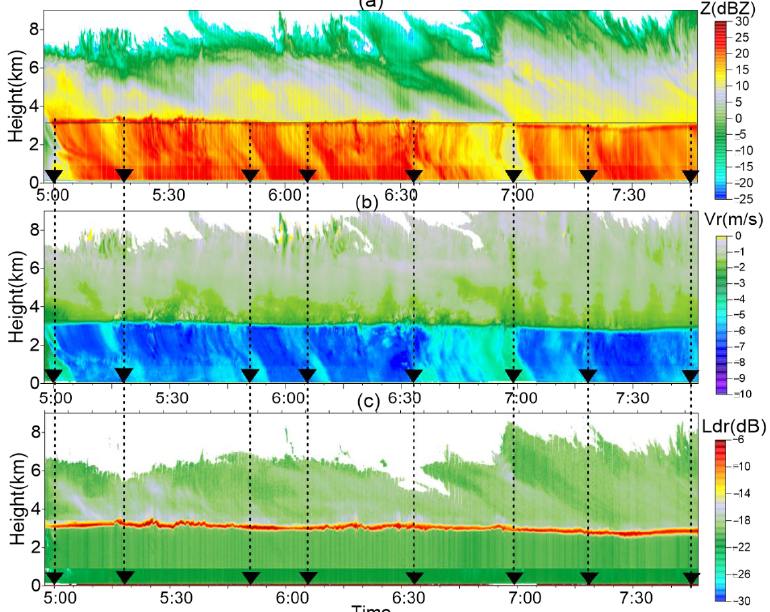
Figure 11. Time – height cross sections of the stratiform rain detected by CR on 19 August 2021, from 4:47 – 7:57 with ( a ) Z (dBZ), ( b ) Vr (m/s) and ( c ) LDR (dB). The black triangles on the horizontal axis mark the BP occurring moment. The black horizontal lines mark the 0 °C line. The black dotted vertical lines extend from the black triangle to the 0 °C-layer bright band between 3.1 and 3.2 km.